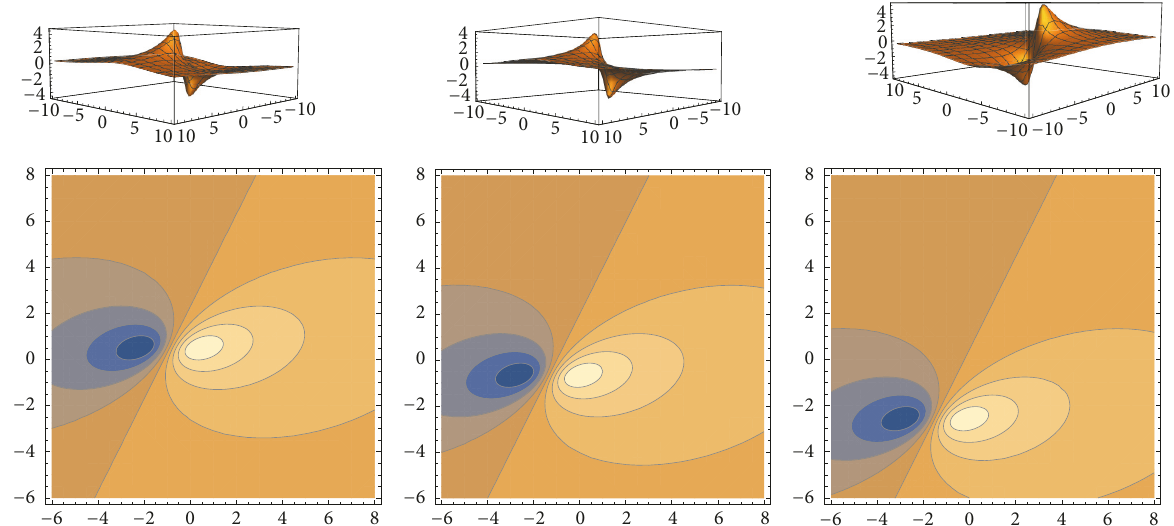
Figure 2: Profiles of equation (1) with 𝑡 = −1, 0, 5 : 3d plots (top) and contour plots